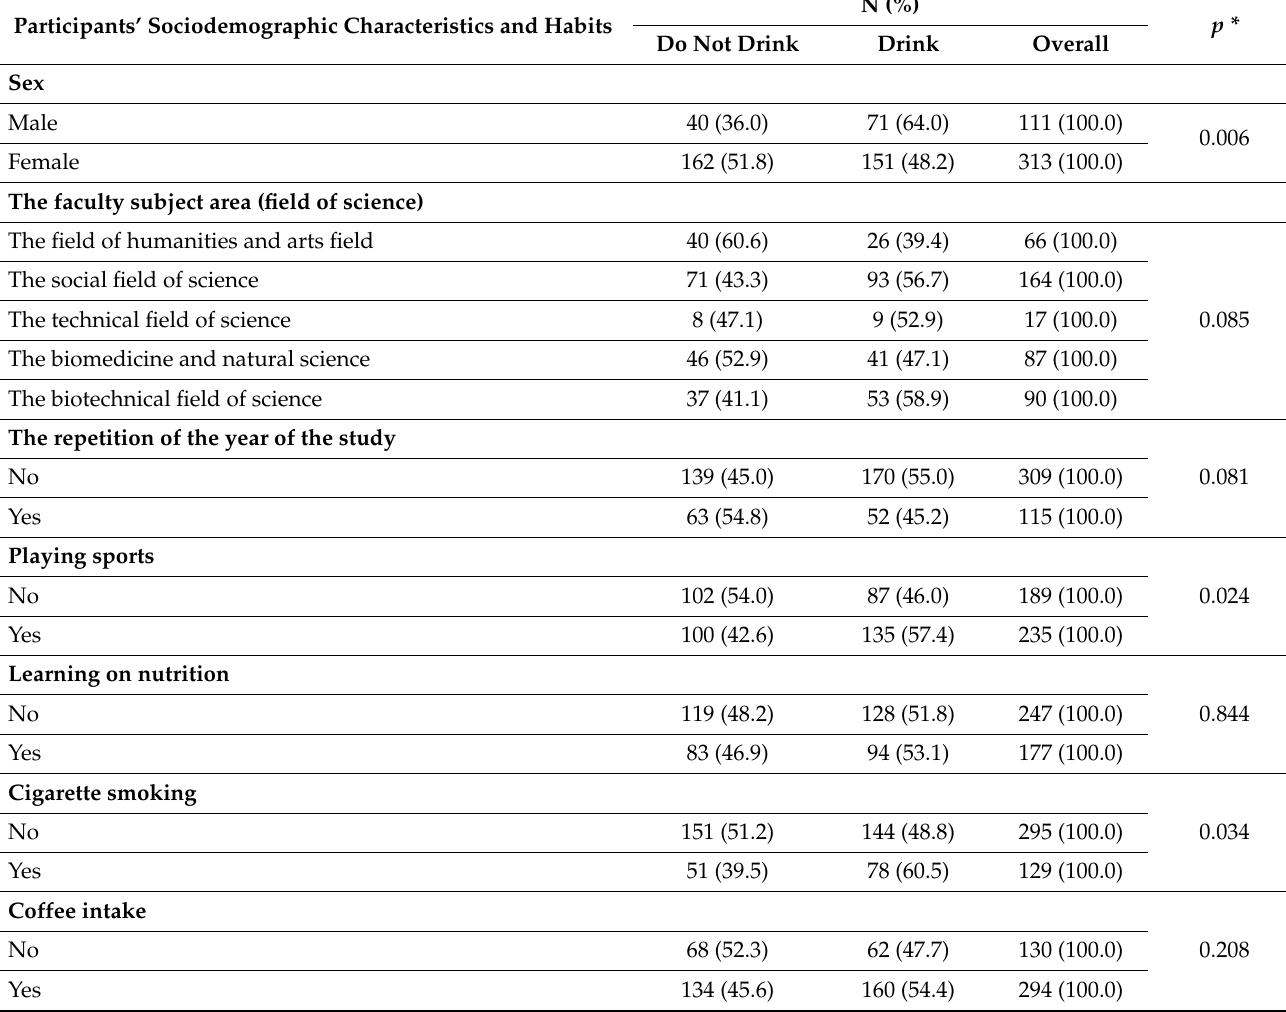
Table 3. Participants’ consumption of EDs according to their sociodemographic characteristics and